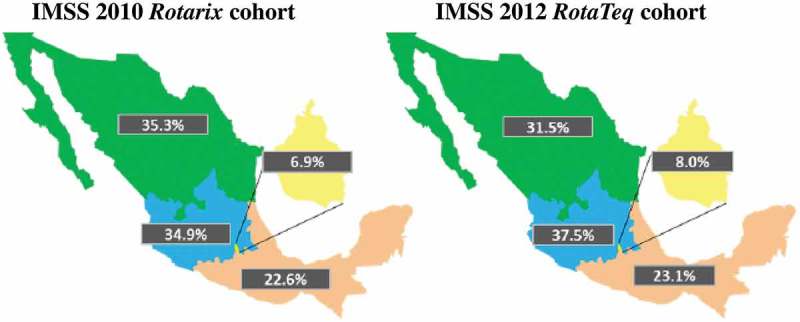
Distribution of Rotarix and RotaTeq eligible infants (%) by region.IMSS: Instituto Mexicano del Seguro Social; Rotarix: two-dose rotavirus vaccine; RotaTeq: three-dose rotavirus vaccine; Green: North region; Blue: Central region; Pink: South region; Yellow: Mexico City.